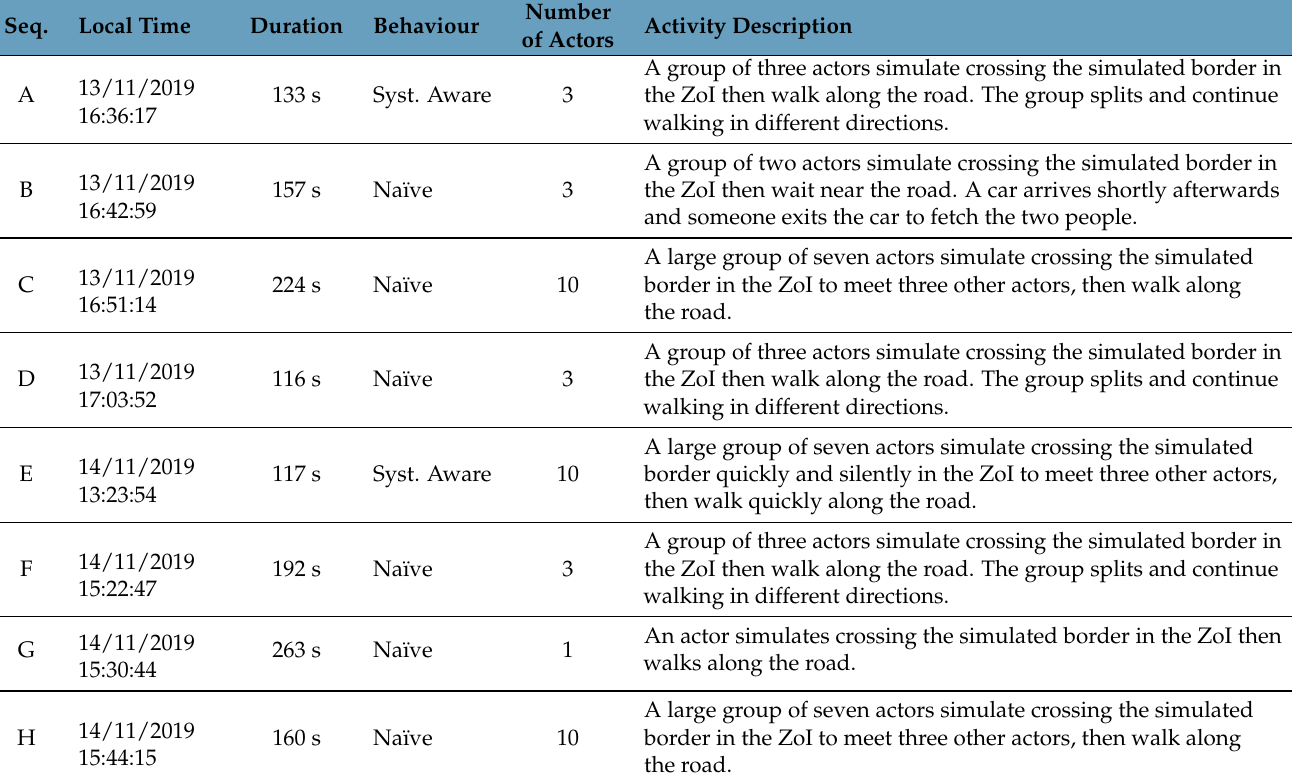
Table 2. Characteristics of the sequences used for